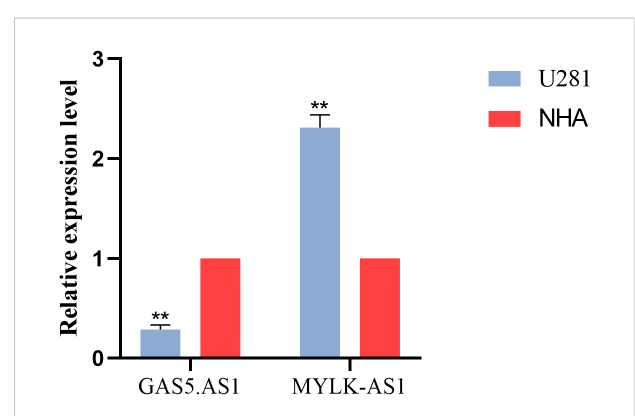
FIGURE 7 Validation of the expression level of GAS5.AS1 and MYLK.AS1 in cell lines and